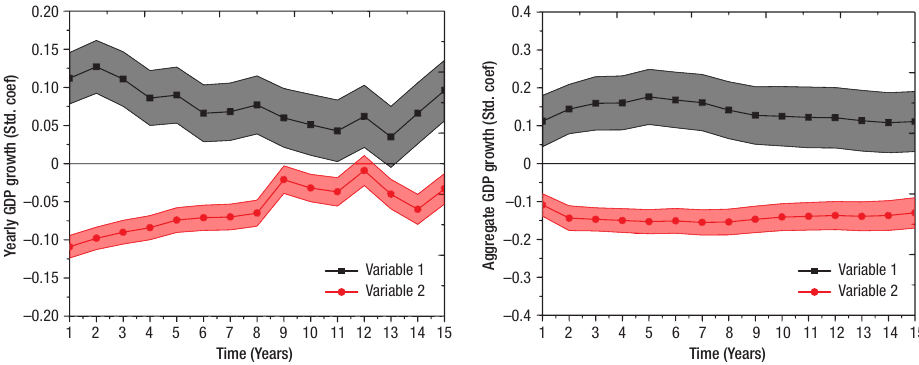
Fig. 2. Relation between the time scale and the standardized coefficients for the composite variables Notes: composite variables represent the trade cycles for category SIC 2. Shaded areas depict a